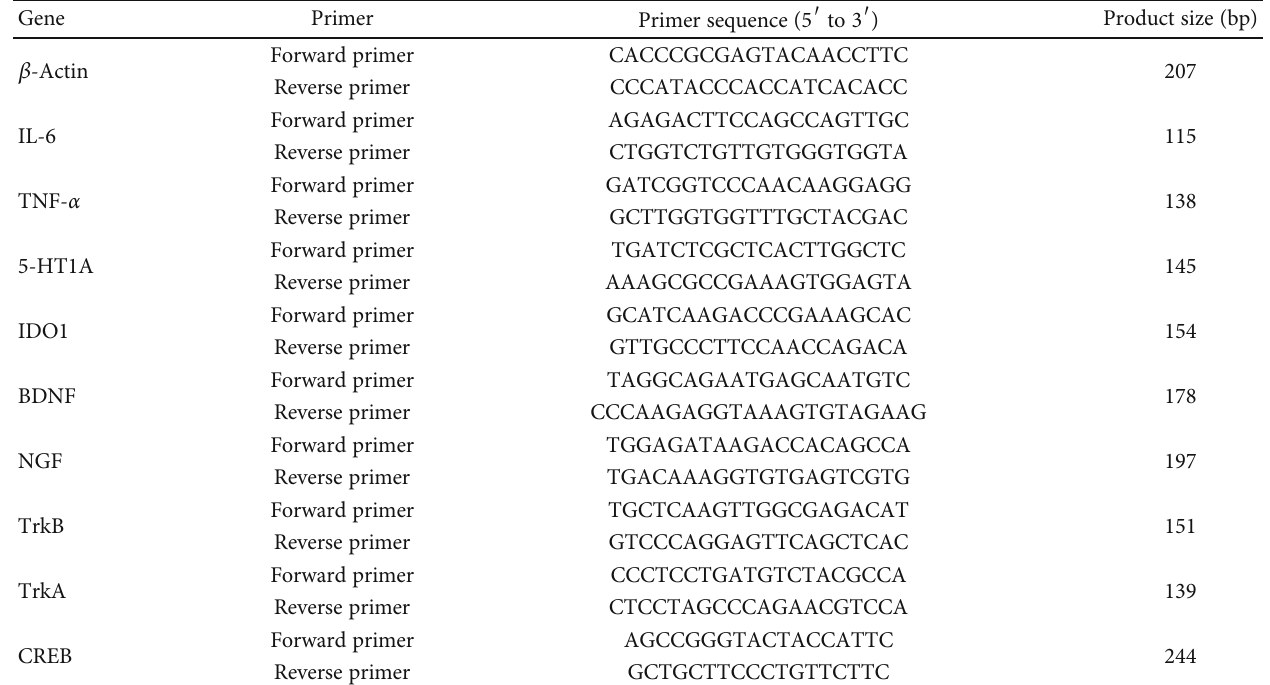
Figure 1: Identi fi cation of rat primary hippocampal neurons (20x). The hippocampal neuronal cells were incubated with anti-NeuN antibody (red) and DAPI (blue) and were observed by a laser scanning confocal microscope. Table 1: Gene primer